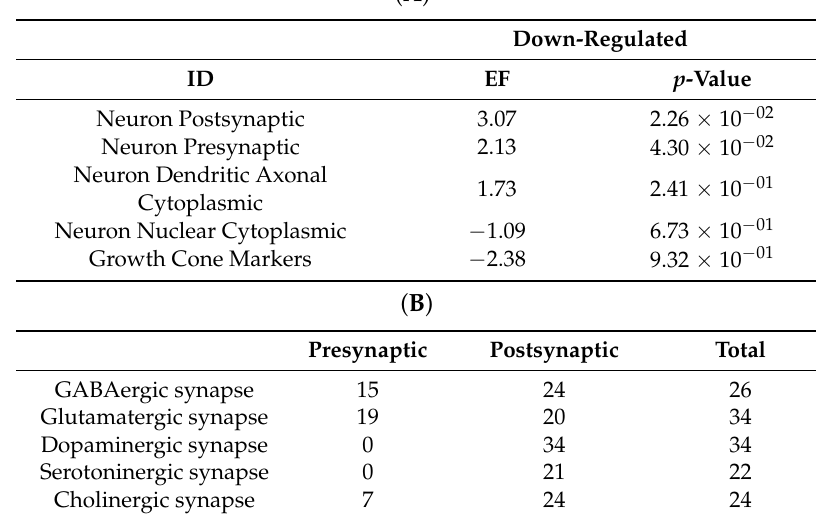
Table 6. ( A ) Signature analysis of specific neuronal zones in the down-regulated DEGs. EF means enrichment factor, which is the number of times that there are more genes down-regulated or up-regulated than expected by chance. Positive EF means there is an over-representation of genes of cell type, while negative EF means an under-representation of genes of cell type. ( B ) Discrimination of DEGs in presynaptic and postsynaptic region. Genes annotated in synapsis were located in presynaptic or postsynaptic region according KEGG